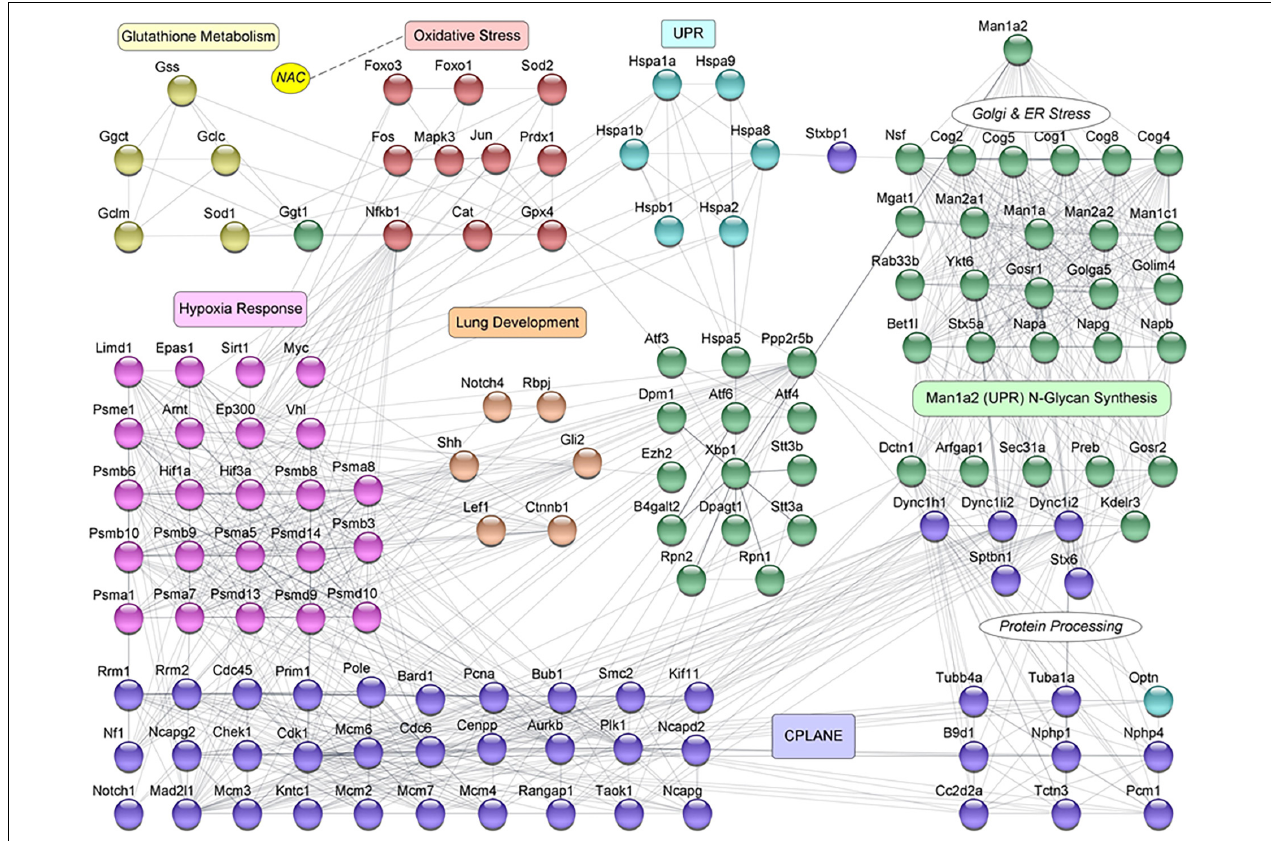
FIGURE 5 | Protein-protein interaction (PPI) network for selected proteins corresponding to 140 differentially expressed genes in NAC-treated newborn pups. This mechanistic network represents the essence of regulatory crosstalk between the key genes that belong to the different functions of interest. The nodes are color coded to represent the different functional mechanisms that are involved in the process of Lung Development. They are represented as: Man1a2 N-Glycan Synthesis (green), Unfolded Protein Response (UPR, light blue), Oxidative Stress (maroon), Glutathione Metabolism (olive green), Hypoxia Response (pink), Lung Development (orange brown), and CPLANE (purple). Genes in Man1a2 N-Glycan Synthesis, that are involved in Golgi and Endoplasmic Reticulum stress, and protein processing are marked separately, and their interactions with CPLANE genes are evident. The influence of NAC (yellow) on the Oxidative Stress pathway genes is represented by a dotted